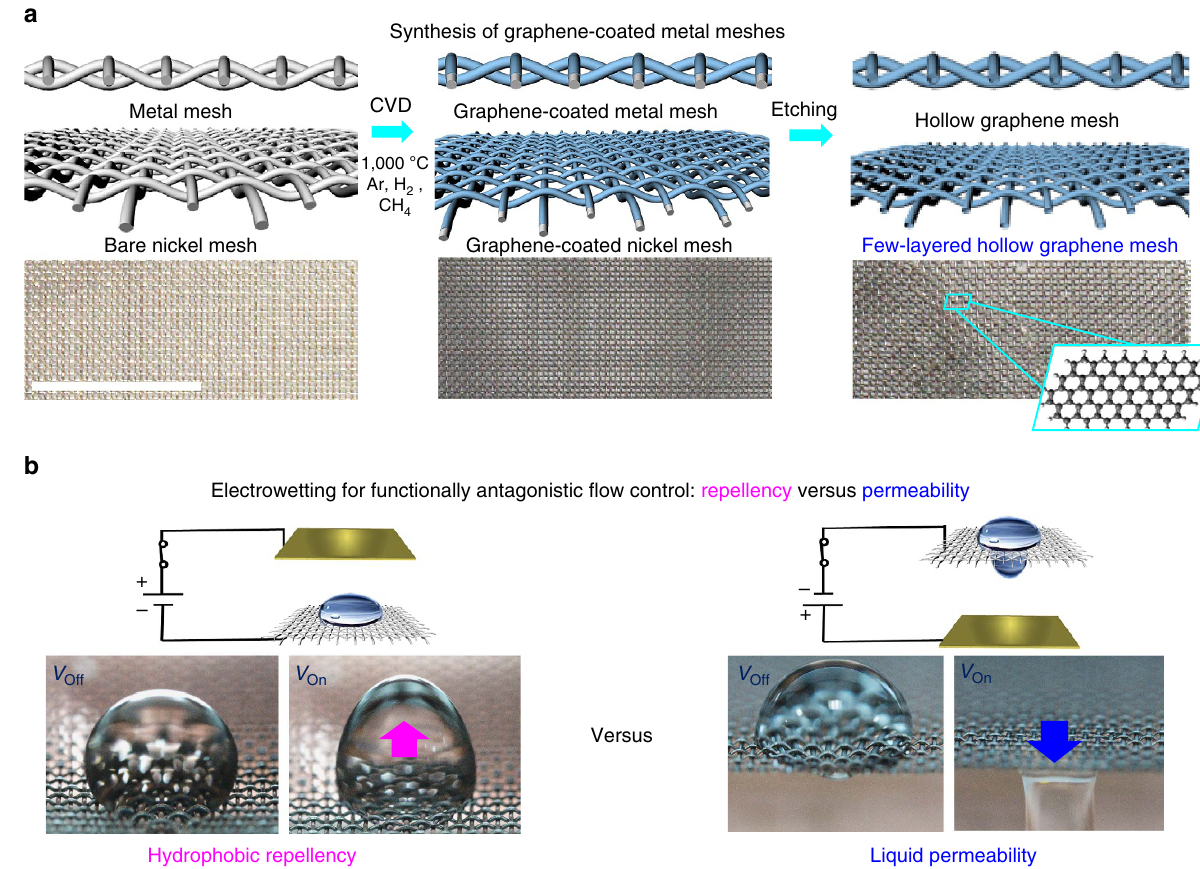
Figure 1 | Schematic of synthetic route to graphene-coated metal mesh and hollow graphene mesh. ( a ) Fabrication steps of graphene-coated metal meshes. Scale bar, 1cm. ( b ) Electrowetting and functionally antagonistic flow control using liquid repellency and liquid